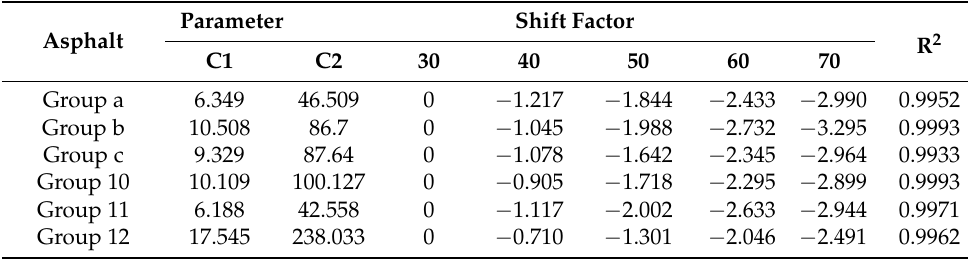
Figure 5. Frequency scanning test results. ( a ) Group a, ( b ) Group b, ( c ) Group c, ( d ) Group 10, ( e ) Group 11, ( f ) Group 12. Table 6. Shift factors and C1 and C2 parameter values of materials at different test temperatures (reference temperature: 30 ◦